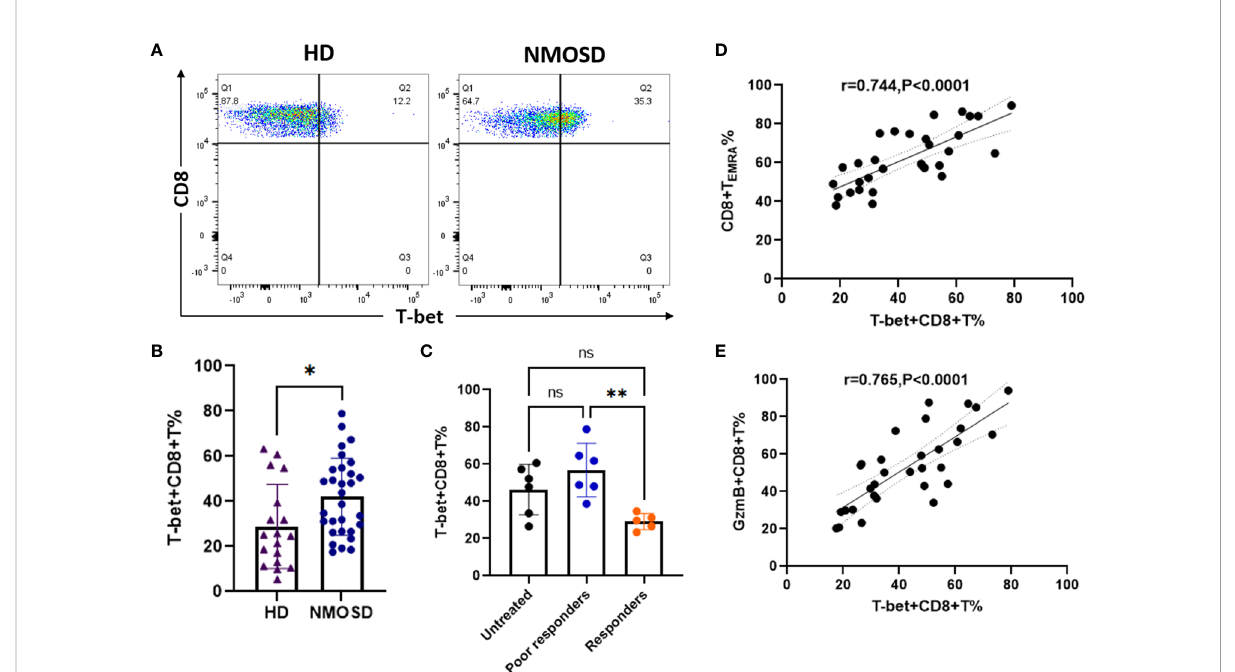
FIGURE 5 Upregulation of the transcription factor T-bet is associated with high expression of GzmB in circulating CD8+ T cells. (A) The fl ow cytometric gating strategy for evaluate levels of T-bet in CD8+ T cells. (B) Comparison of T-bet+CD8+ T cells between patients with NMOSD (n=31) and HDs (n=6) (Mann – Whitney U-test). (C) Comparison of T-bet+CD8+ T cells among untreated patients (n=6), poor responders (n=6), and responders (n=5) (one-way ANOVA with Tukey ’ s multiple comparison test). (D,E) The correlation between T-bet expression and the proportions of CD8+ T EMRA cells (D) or GzmB+CD8+ T cells (E) in patients with NMOSD. GzmB, granzyme B; NMOSD, neuromyelitis optica spectrum disorder. *P<0.05, **P<0.01, and ns (not signi fi